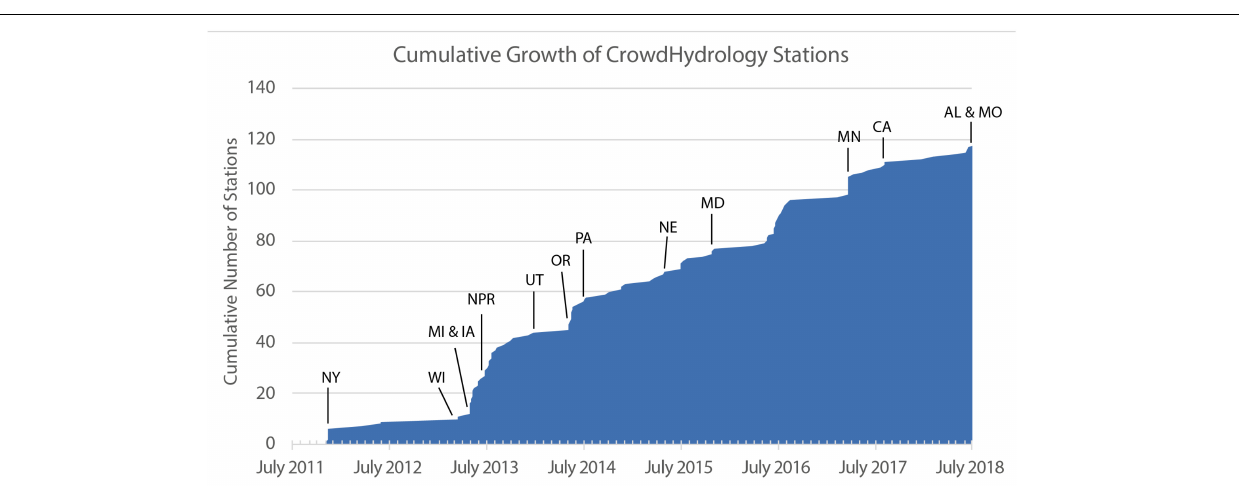
FIGURE 3 | Growth of the CrowdHydrology network. State initials designates the time the first CrowdHydrology station became active. NPR represents date of national radio